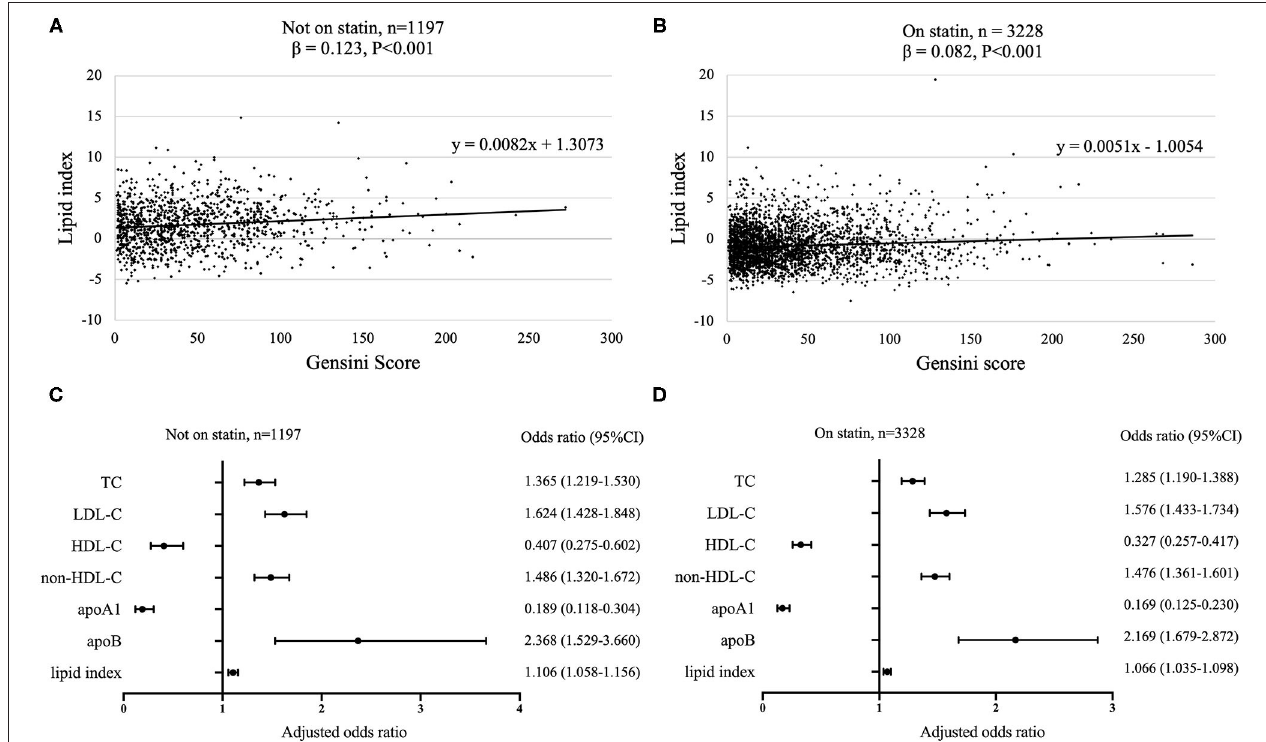
FIGURE 2 | Association between lipids and GS according to statin status. Simple linear regression analyses were used to show the association between lipid index and GS [ (A) not on statin; (B) on statin]. Relationship between lipids and high GS was assessed by multivariate logistic regression models with adjustment for age and gender [ (C) not on statin; (D) on statin]. 95% CI, 95% confidence interval; GS, Gensini score; TC, total cholesterol; LDL-C, low density lipoprotein-cholesterol; HDL-C, high-density lipoprotein-cholesterol; non-HDL-C, non-high-density lipoprotein-cholesterol; apo,